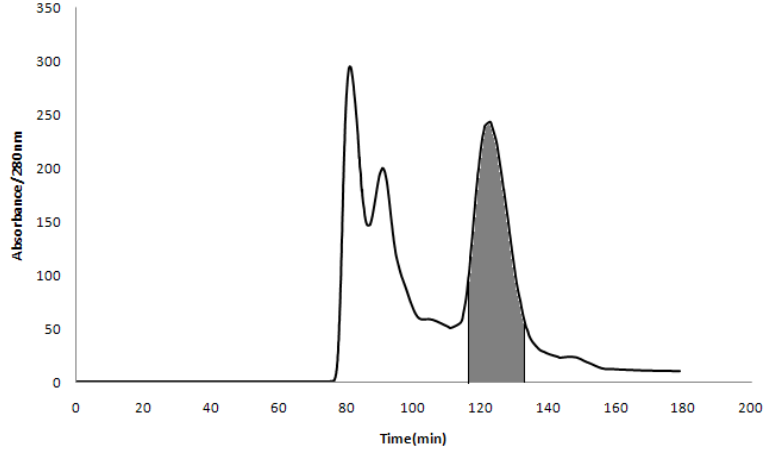
Figure 4. HSCCC chromatogram of the extract from Acanthopanax sessiliflorus (Rupr. & Maxim.) Seem. The shaded peak represents the fraction of cyanidin 3-xylosyl-galactoside.